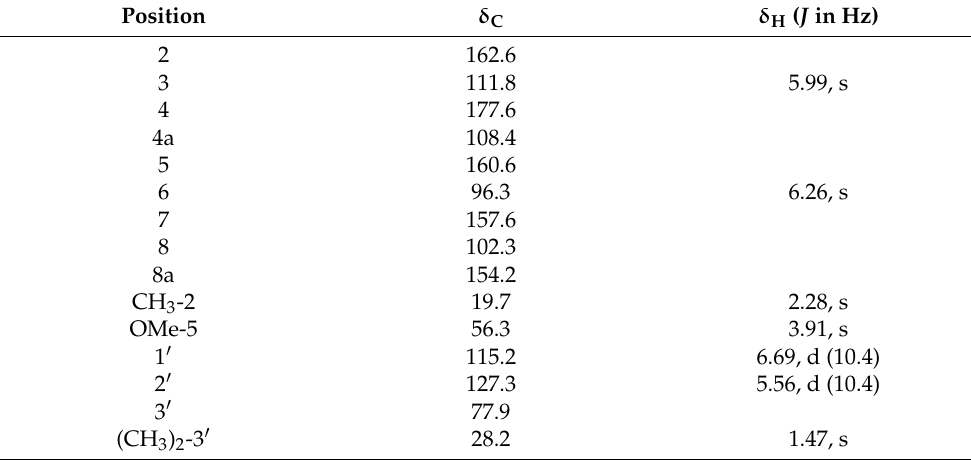
Table A1. 1 H NMR (500 MHz) and 13 C NMR (125 MHz) of O -methylalloptaeroxylin in CDCl 3